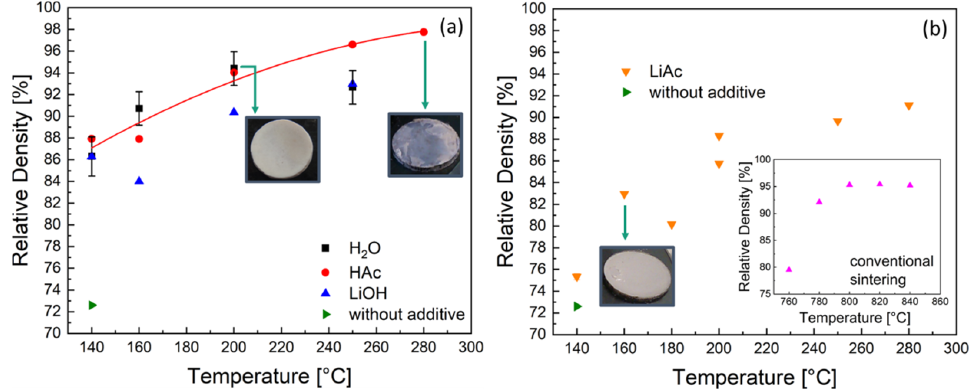
Figure 2. Relative density of the LATP samples prepared by cold sintering as function of the peak temperature (with 1 h dwell time) using ( a ) 20 wt.% liquid (H 2 O = water; HAc = acetic acid solution; LiOH = lithium hydroxide solution) and ( b ) 3.2 wt.% solid lithium acetate (LiAc) sintering additives. Inset in ( b ): relative density of the LATP ceramics prepared by conventional sintering at higher tem- peratures.